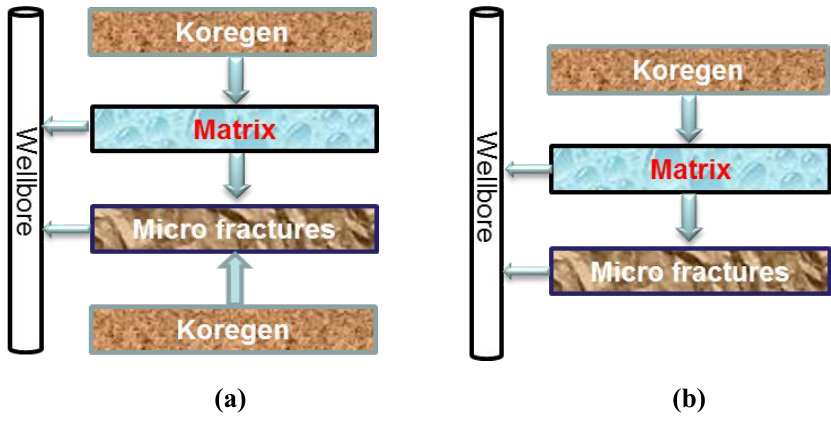
Figure 7—Schematics for shale gas flow in TPTP. (a) F-TPTP. (b)